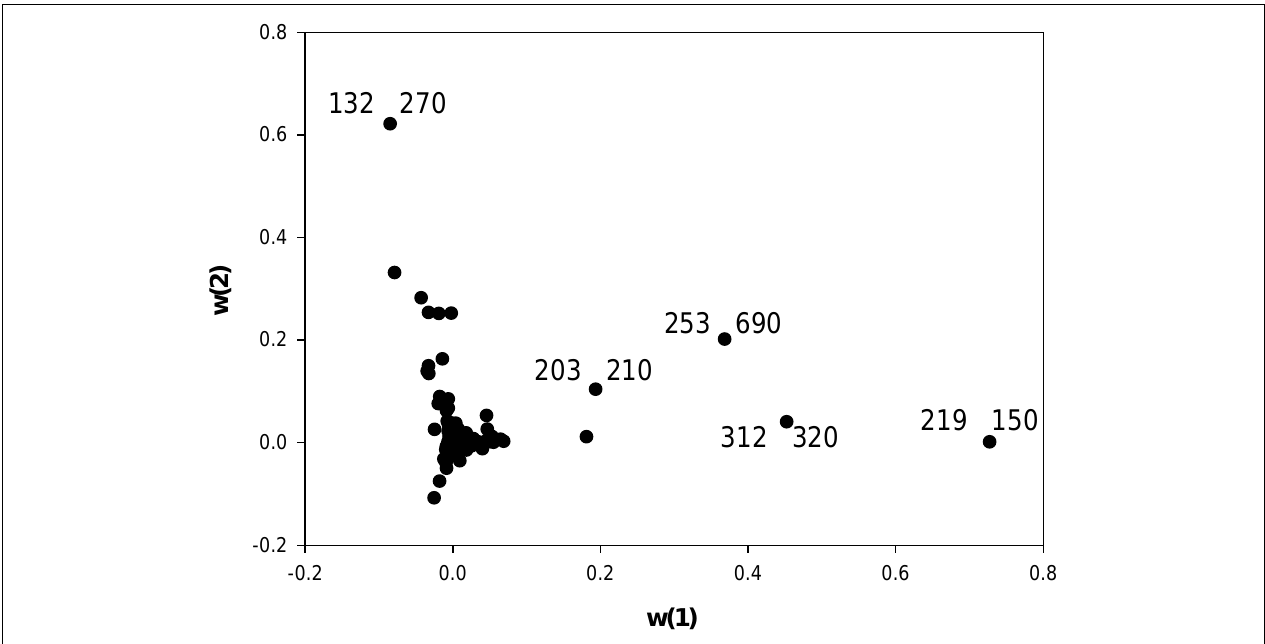
FIGUREA5 | PCA loadings plot of weighting 1 vs weighting 2 of the LC-MS runs of respected tR and m / z obtained from plant set C. PC1: 76%, PC2: 10%. Numbers given are m / z (three digits) followed by retention time in seconds (three digits).